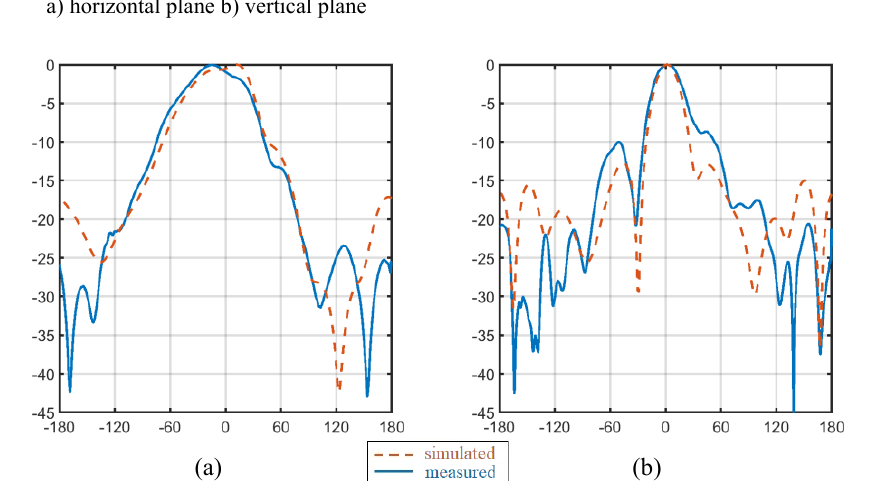
Fig. 3. Simulated and measured patterns at CF=1575